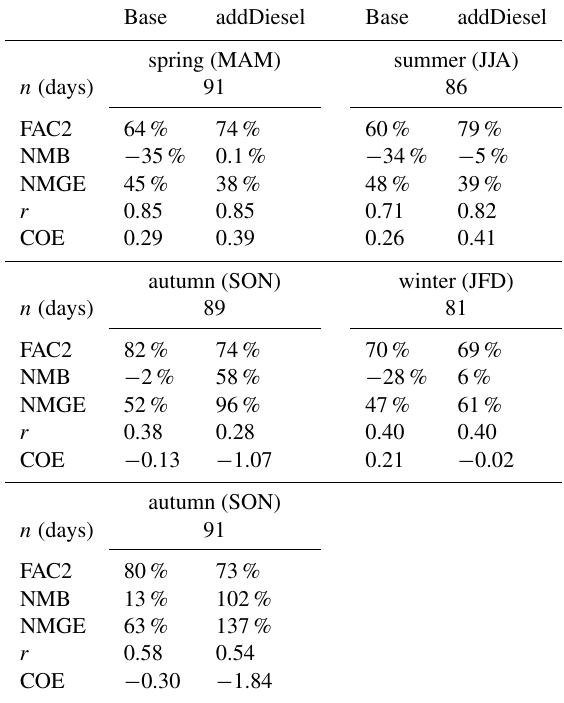
Table 4. Model–measurement comparison statistics for daily SOA at London North Kensington. Autumn is presented with and without the two outliers (23 and 24 October n = 91 and 89,